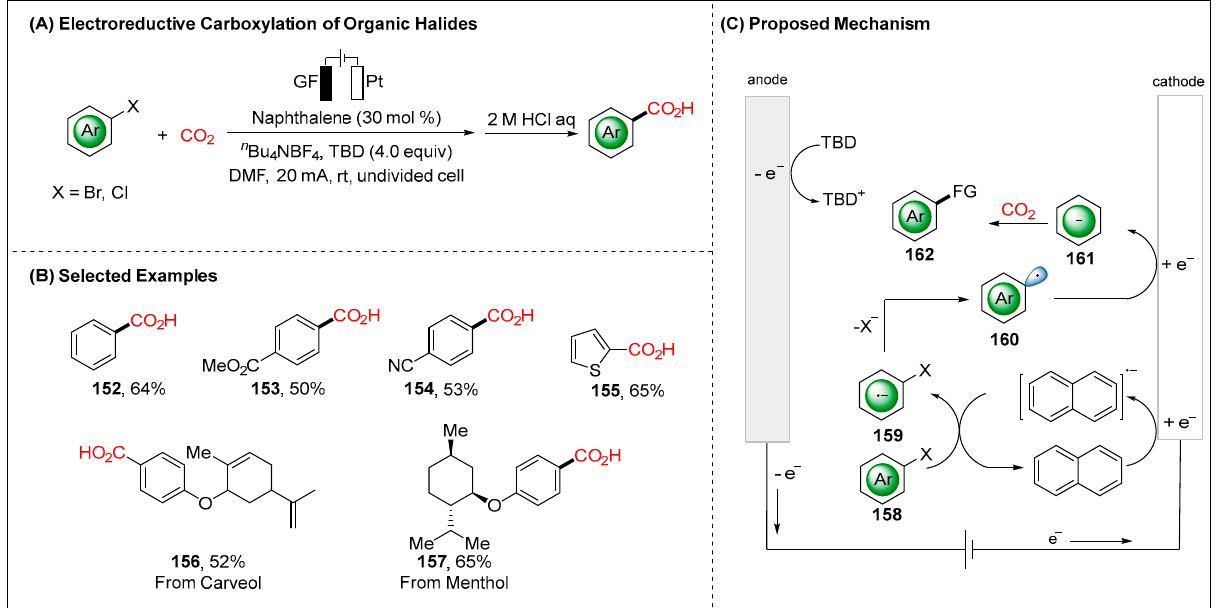
Figure 19. Naphthalene mediated electroreductive carboxylation of aryl halides by Qiu group.